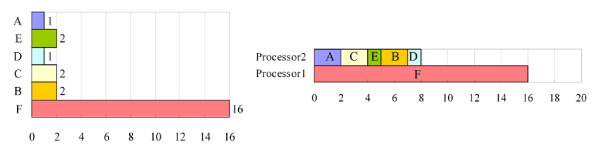
The result of moving long tasks forward in the processing order list. The long tasks are moved forward in the processing order list in Figure 4, yielding the new processing order list. The overall processing time for a two-processor computer is 16 units, which still exceeds the optimal processing time.